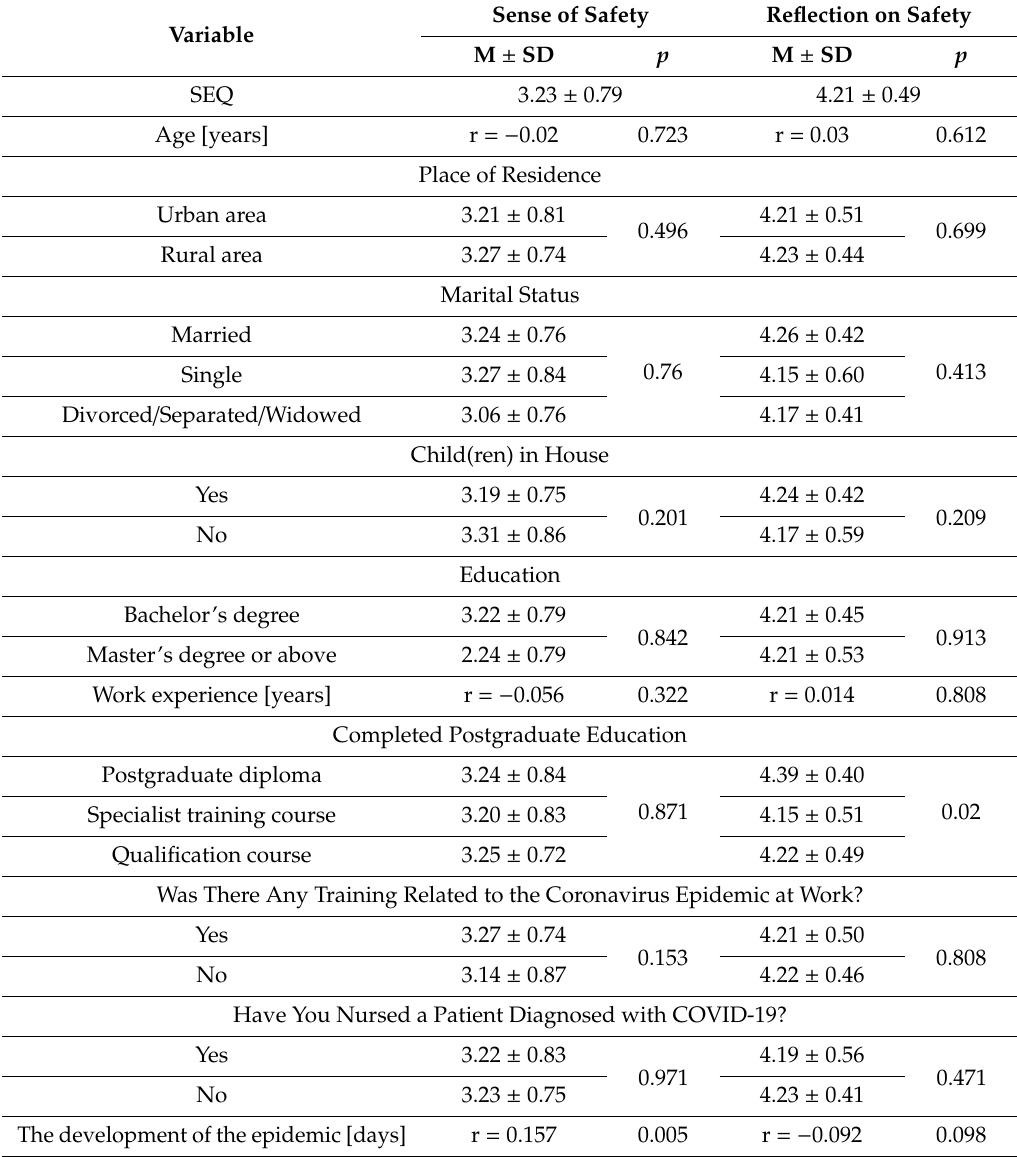
Table 5. The level of experiencing security and selected sociodemographic